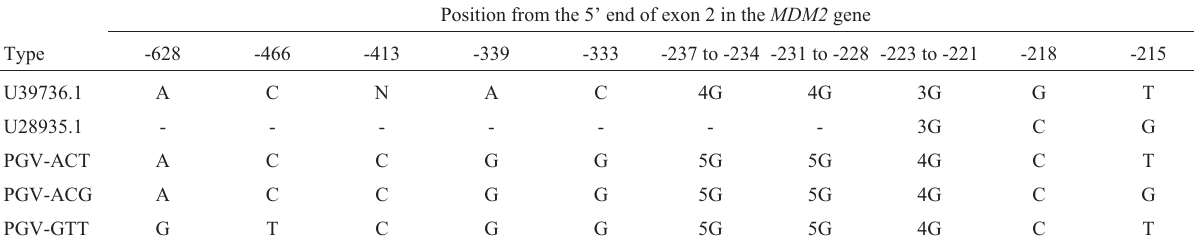
Table 3 - MDM2 promoter sequences in vector constructs.